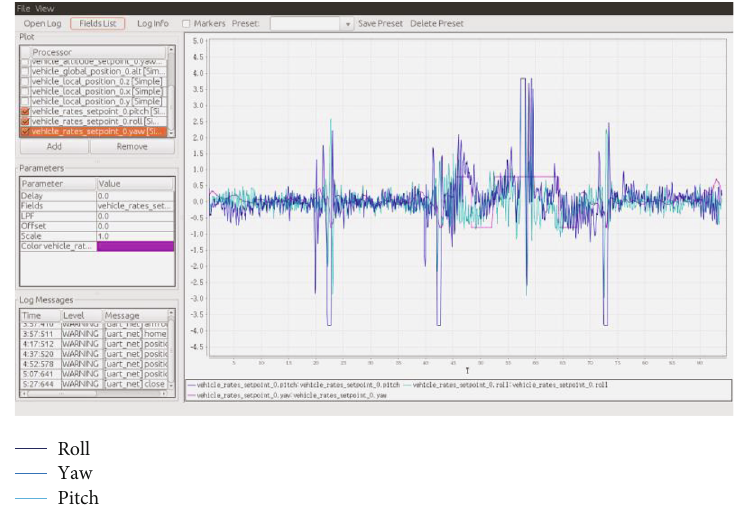
Figure 16: UAV fl ight attitude